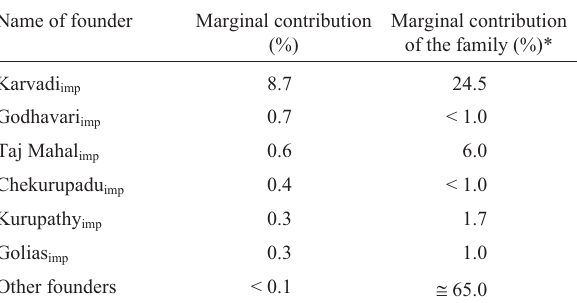
Table 3 - Genetic contributions of the principal founders and the principal descendants in the Nellore strain. Name of founder